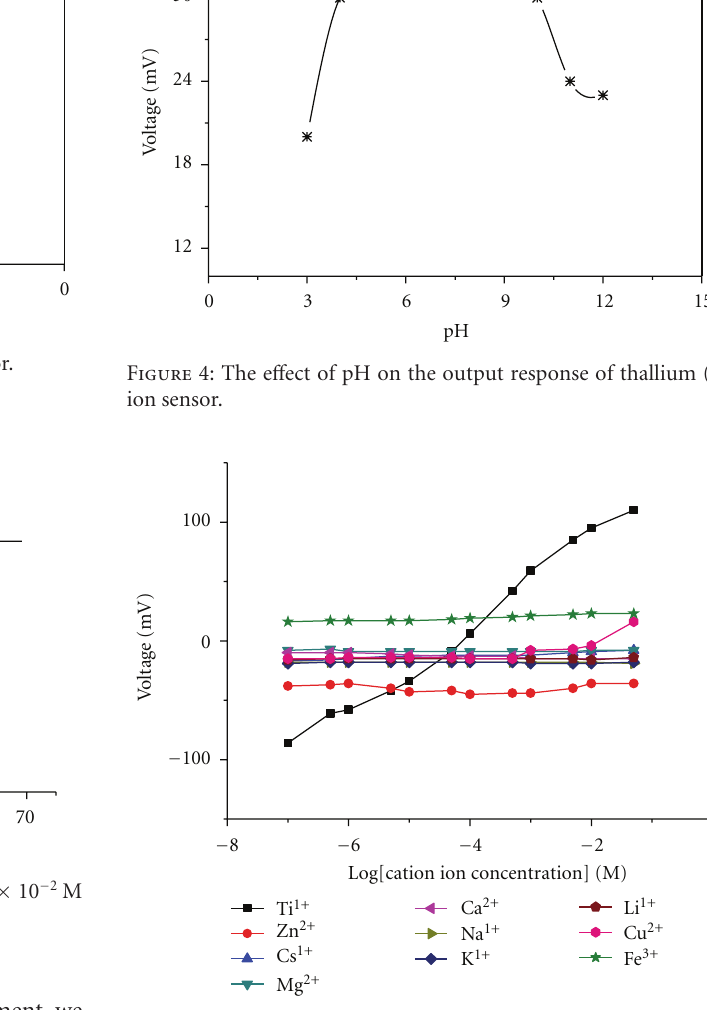
Figure 5: The behaviour of thallium ion sensor in the presence 1 × 10 − 4 M of interfering